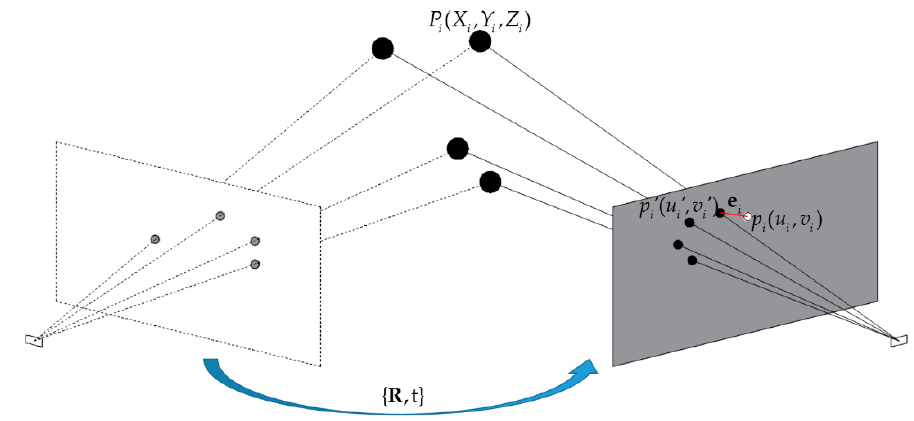
Figure 9. Illustration of re-projection error.